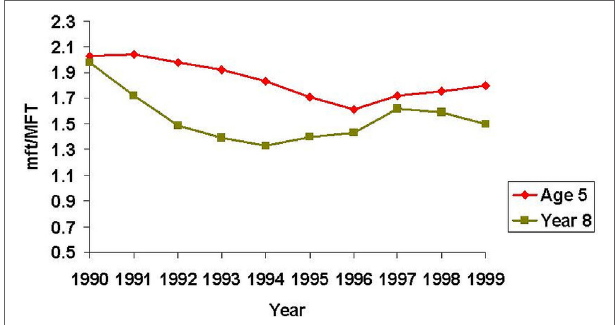
FiguRe 9 | Trends in dental caries severity among 5-year-old and year 8 (12- to 13-year-old) children during the 1990s (111).